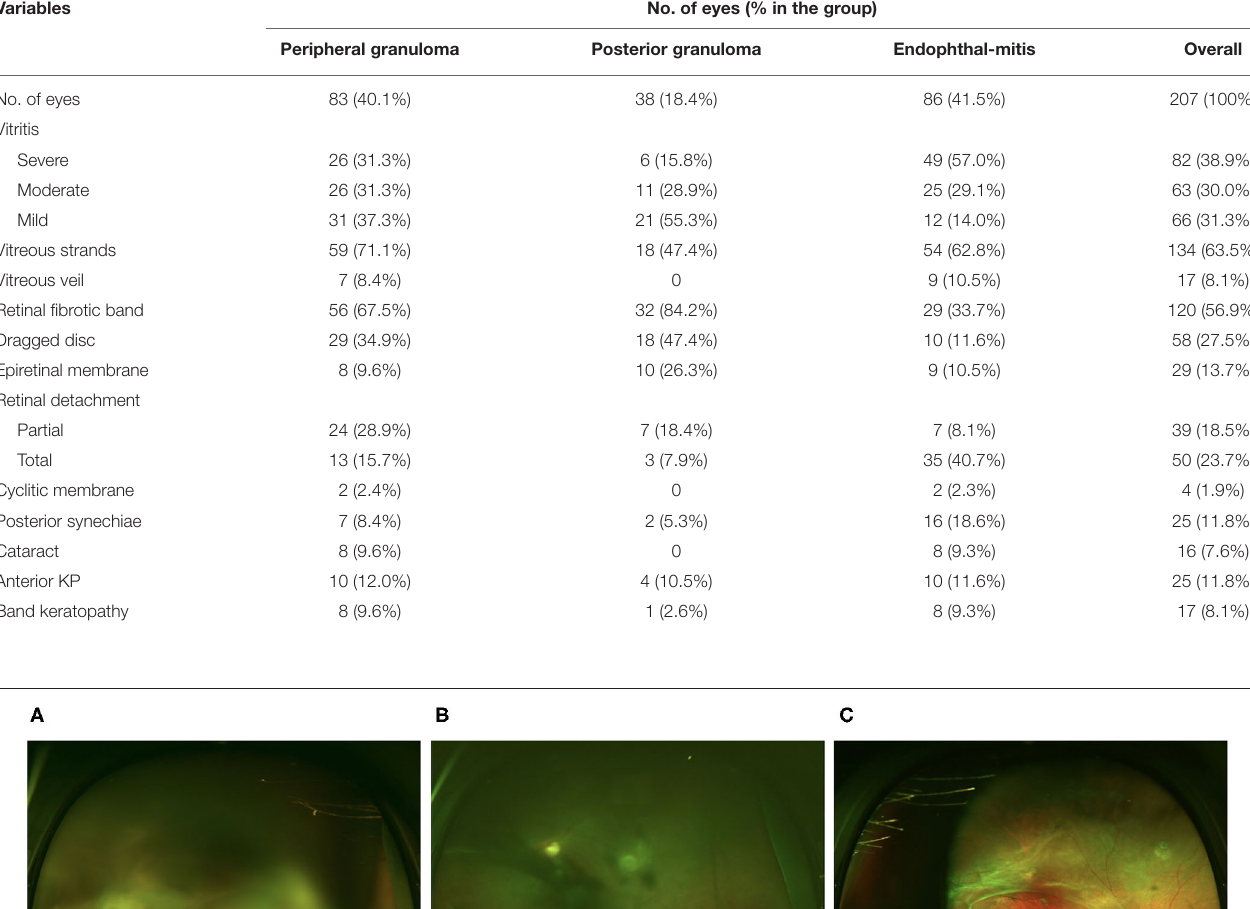
Frontiers in Medicine |